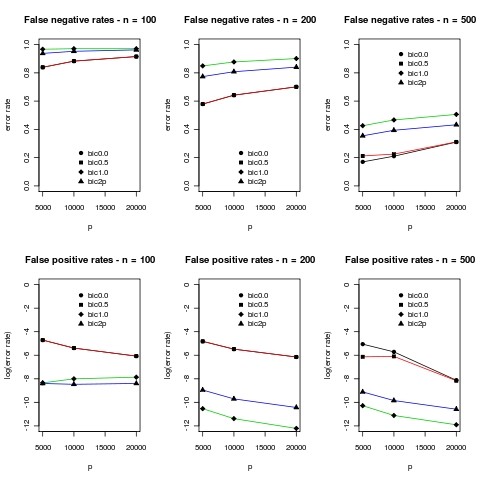
Results of simulations for m = 10. Mean error rates over 10 simulations are plotted. The standard deviations were typically less than 5% and difficult to distinguish on the plots so they were omitted. In the plots bic0.0 corresponds to γ = 0 in (7), bic0.5 to γ = 0.5, bic1.0 to γ = 1.0 and bic2p corresponds to BIC defined by equation (8). We use a log scale for the false positive rates because the number of zero entries is so large that it is difficult to make sense of the numbers in the original scale.